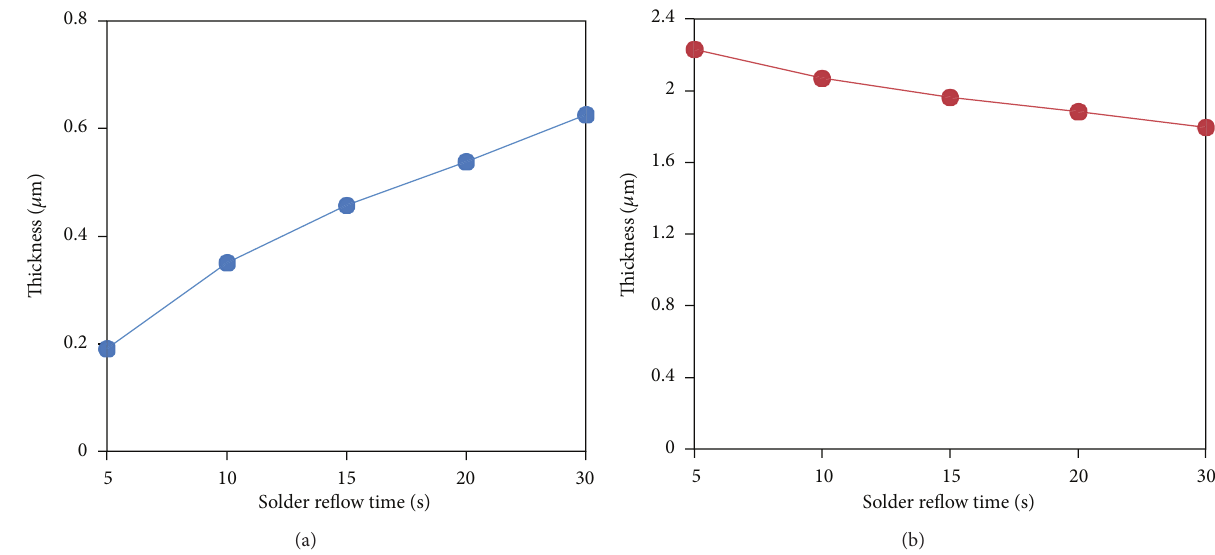
Figure 13: (a) Cu 3 Sn and (b) Cu 6 Sn 5 IMC layer thickness versus reflow time at 230 ∘